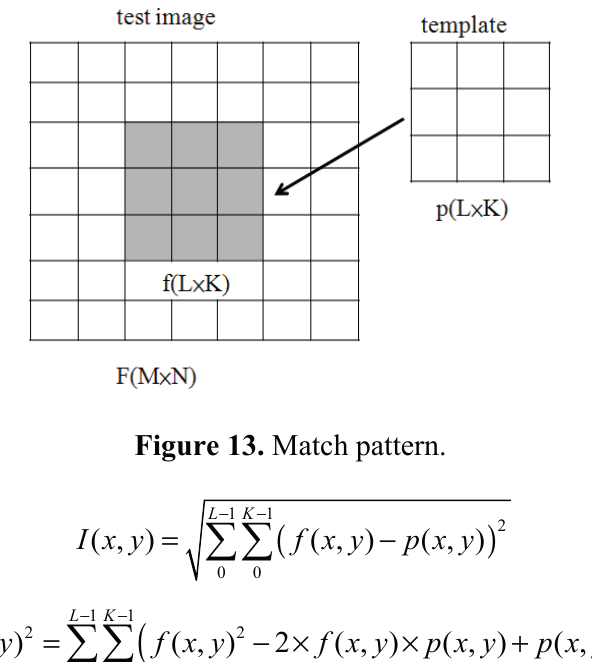
Figure 13. Match pattern.